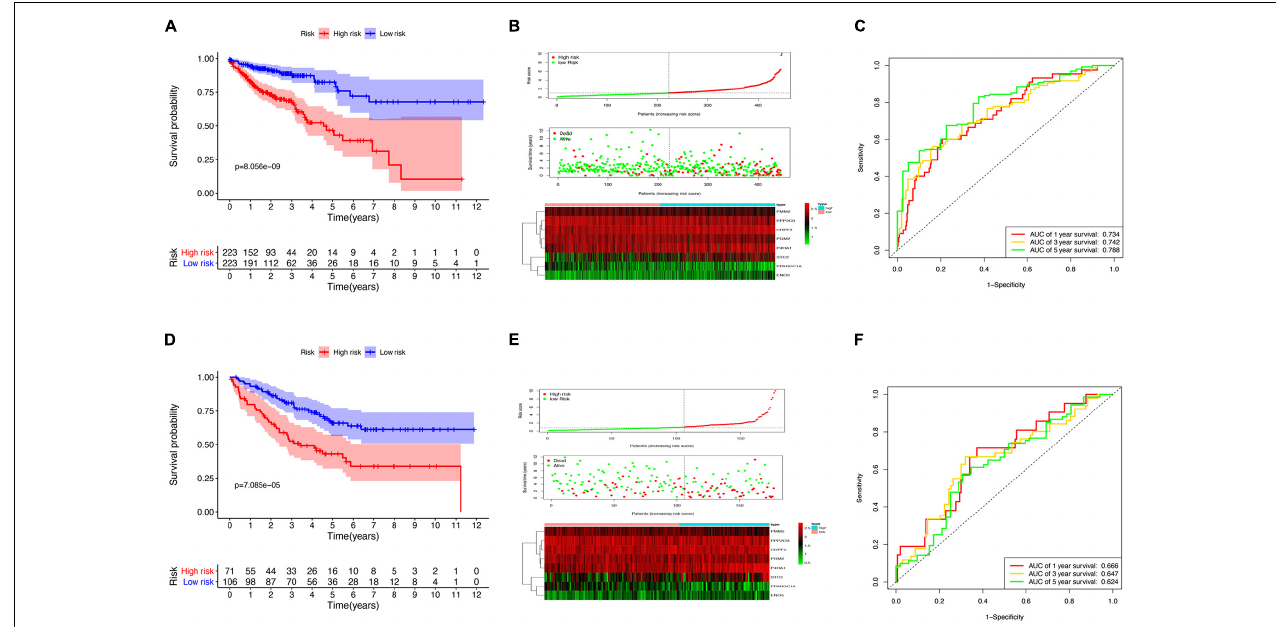
FIGURE 4 | Risk model construction and validation. (A) Kaplan–Meier plots illustrating the worse overall survival (OS) rate in the high-risk group compared with the low-risk group patients in The Cancer Genome Atlas (TCGA) cohort. (B) Expression heatmap, risk score distribution, and survival status in TCGA cohort. (C) Time-dependent area under the curve (AUC) of the receiver operating characteristic (ROC) curve of the 1-, 3-, and 5-year OS rates of TCGA patients. (D) Kaplan–Meier plots of worse OS in the high-risk patients compared with low-risk patients in the GSE17536 cohort. (E) Expression heatmap, risk score distribution, and survival status in the GSE17536 cohort. (F) Time-dependent AUC ROC curve of 1-, 3-, and 5-year OS rates of patients in the GSE17536